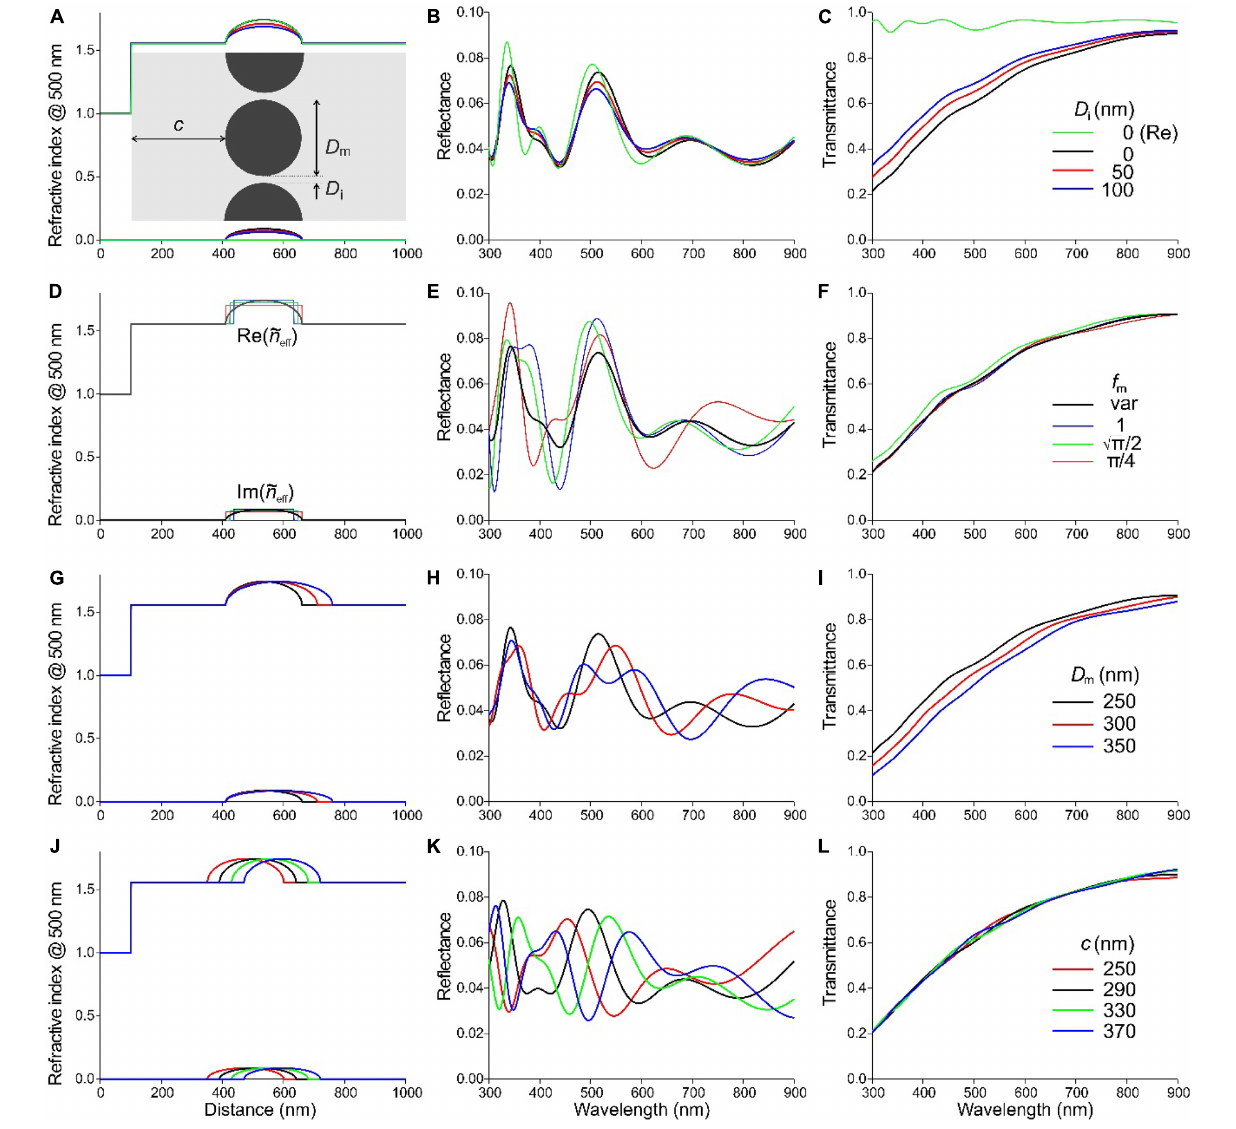
FIGURE 3 | Effective-medium-multilayer modeling of a S. vulgaris barbule. (A–C) Rodlet melanosomes with diameter D m = 250 nm and interdistance D i = 0, 50, and 100 nm embedded in a keratin barbule at a distance c = 310 nm from the border. In the legend of (C) , (Re) concerns the case where the refractive index is real, i.e., the melanin is absorptionless. (D–F) The case of a layer of rodlet melanosomes with varying melanin fraction ( f m var) compared with discrete melanin layers of different melanin fraction and layer thickness (see text for details). (G–I) Melanosomes with diameter D m = 250, 300, and 350 nm. (J–L) Layer of melanosomes, diameter D m = 250 nm, interdistance D i = 0 nm, with cortex thickness c = 250, 290, 330, and 370 nm. (A,D,G,J) Profiles of the real and imaginary refractive index at 500 nm. The barbule (and cortex) surface is at abscissa (distance) value 100 nm. (B,E,H,K) Reflectance spectra. (C,F,I,L) Transmittance